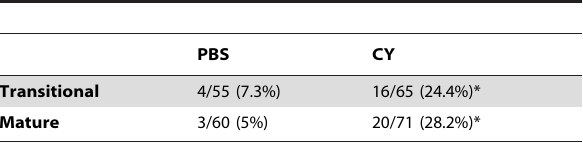
Table 6. Frequency of high affinity DNA-reactive B cells in R4A Tg mice treated with CY and BAFF-R-Ig.